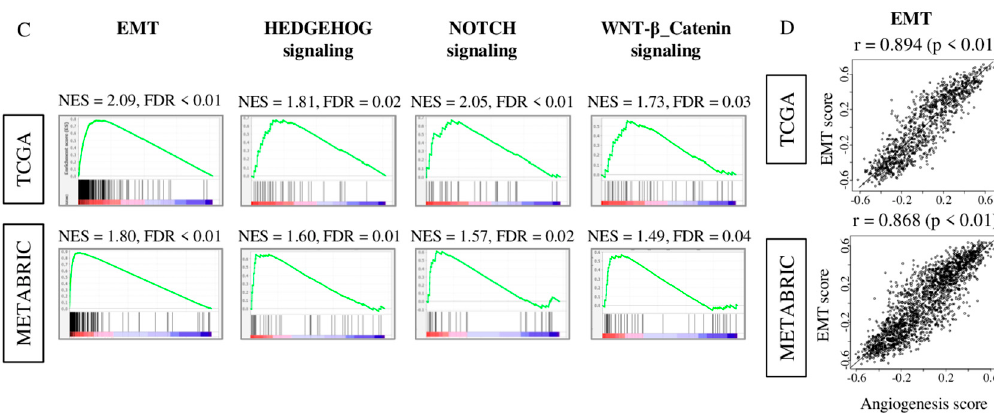
Figure 5. Gene Set Enrichment Assay (GSEA) comparing low and high angiogenesis pathway score tumors with enrichment gene sets in high angiogenesis pathway score group in both the TCGA and METABRIC cohorts. Correlation plot of ( A ) immune response gene sets; interferon (IFN)- γ , and IL2-STAT5 signaling, ( B ) Inflammatory response gene sets; Inflammatory response, IL6-JAK-STAT3 signaling, TNF- α signaling via NFkB, TGF- β signaling and hypoxia, ( C ) metastasis-related gene sets; epithelial mesenchymal transition (EMT), HEDGEHOG signaling, NOTCH signaling and WNT- β catenin signaling with normalized enrichment score (NES) and false discovery rate (FDR). The median was used as cut-off to divide into high and low score groups within each cohort. ( D ) Correlation plots of the angiogenesis score and EMT pathway score of both cohorts. p value was analyzed with spearman r correlation.